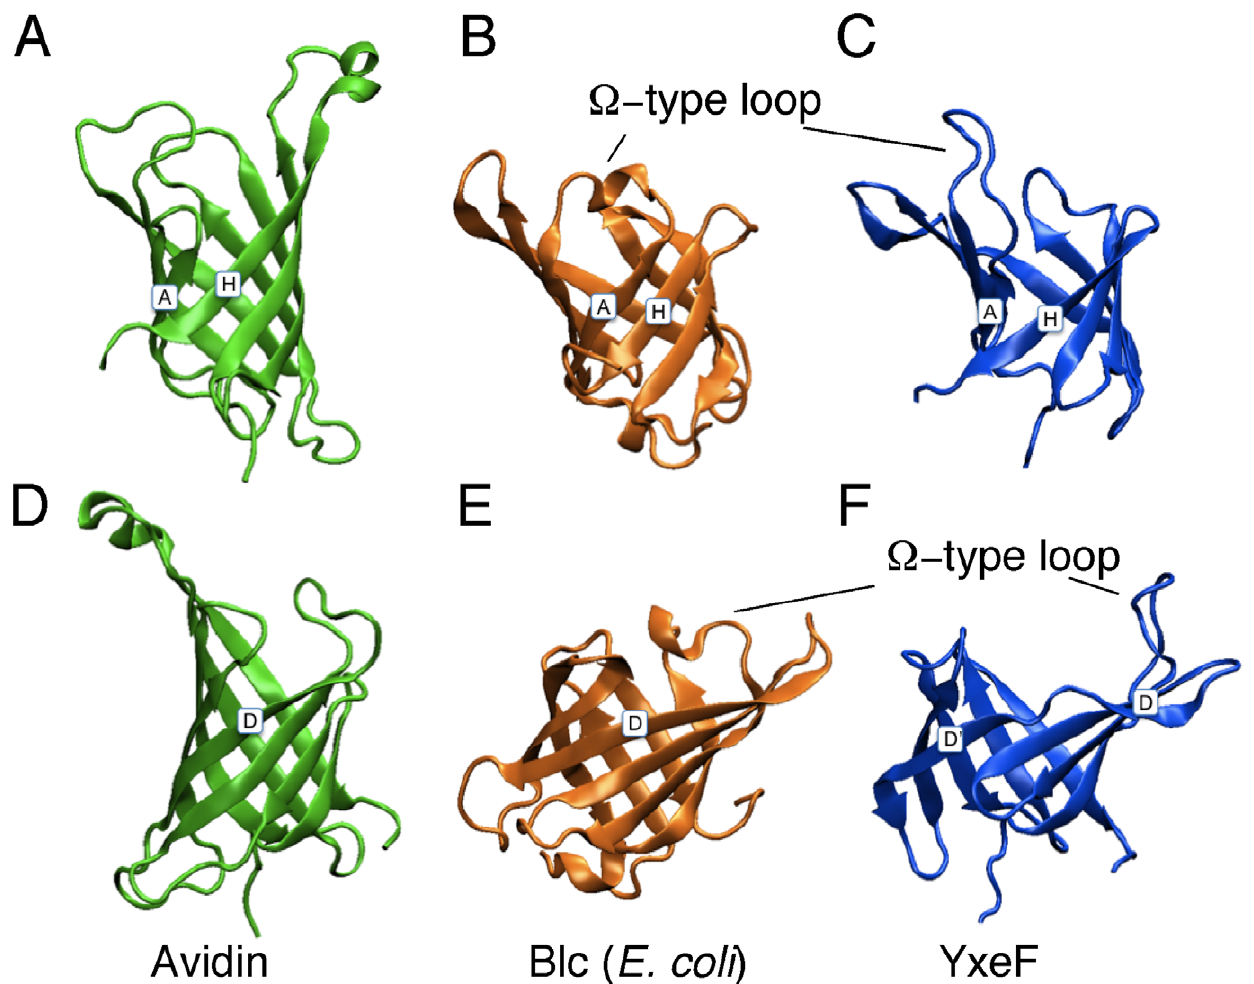
Figure 6. Comparison of b -barrels. Ribbon drawings of b -barrels of avidin (PDB ID 1AVD, green) in (A) and, after rotation by 180 u , in (D); bacterial lipocalin Blc from E. coli (PDB ID 3MBT, orange) in (B) and (E); YxeF in (C) and (F) (PDB ID 2JOZ, blue). For clarity, the disordered terminal polypeptide segments of YxeF, as well as the corresponding segments in avidin and Blc, are not shown. In (A)–(C), b -strands A and H are labeled, while in (D)–(F) b - strand D is